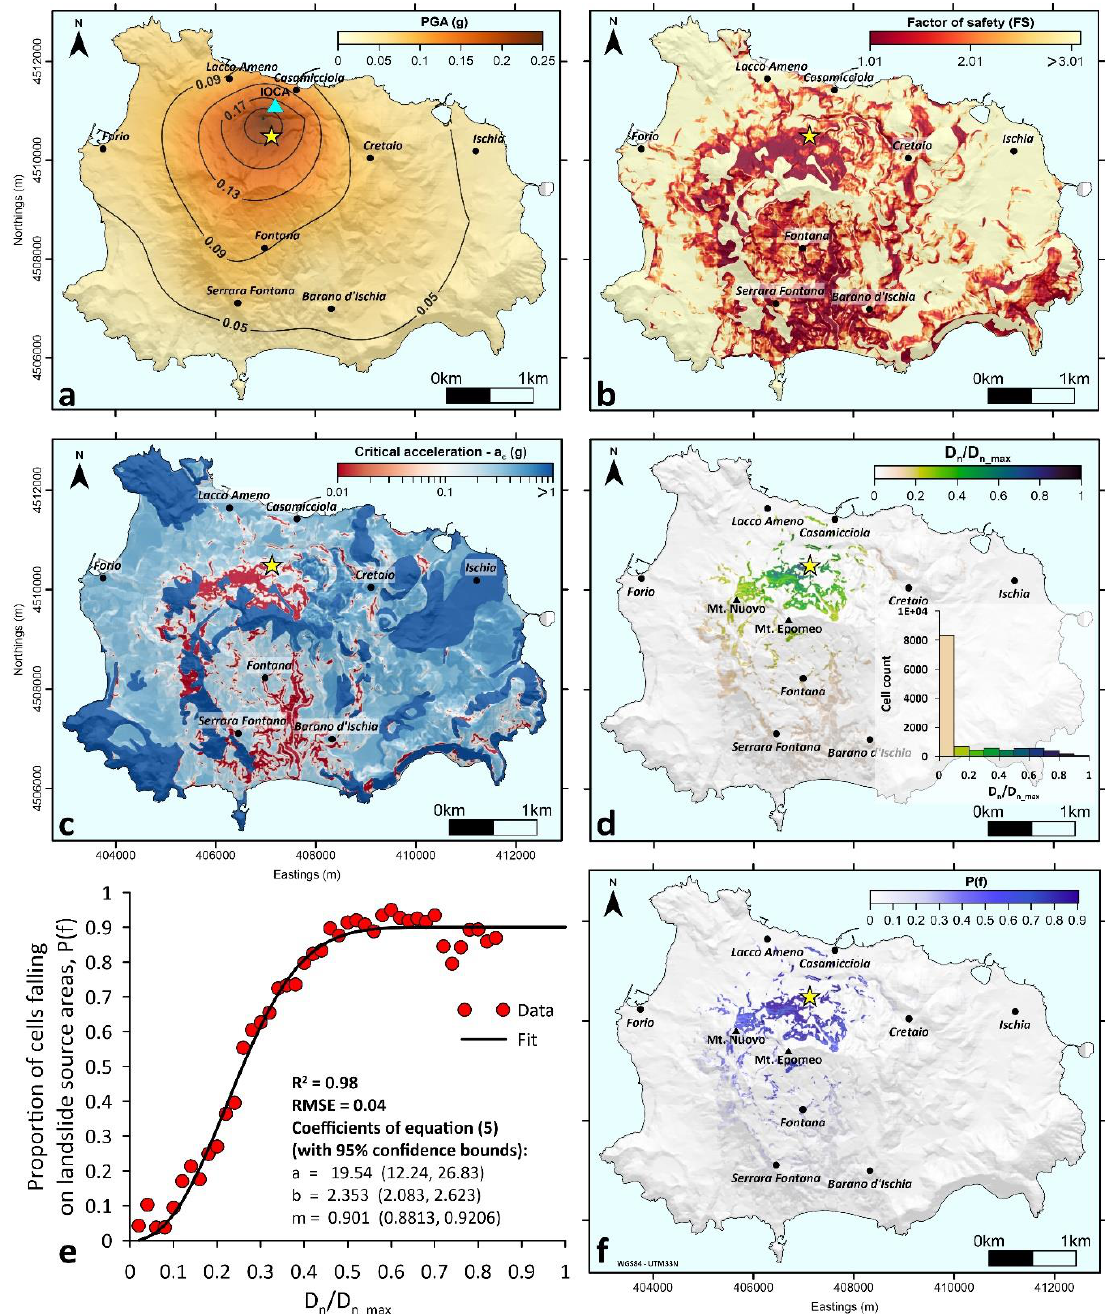
Figure 6. Results for Ischia Island. ( a ) Estimated horizontal peak ground acceleration ( PGA) distribution according to Equation (4); ( b ) static factor of safety ( FS) distribution according to Equation (2); ( c ) a c distribution according to Equation (1); ( d ) D n /D n_max distribution according to Equation (3); ( e ) P(f) curve (black line) obtained by best fitting Newmark displacement data (red dots) with Equation (5); ( f ) P(f) map associated with the calculated Newmark displacements. The yellow star identifies the Ischia earthquake epicenter.